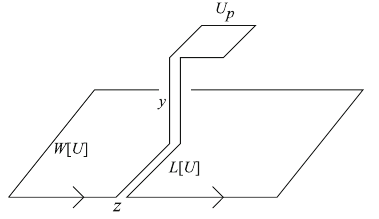
Fig. 1 The setup of the operator W [ U ] L [ U ] U P L † [ U ] in (1). z is the position at which the Schwinger line L [ U ] is inserted, and y is the distance from the Wilson loop W [ U ] to the plaquette U P